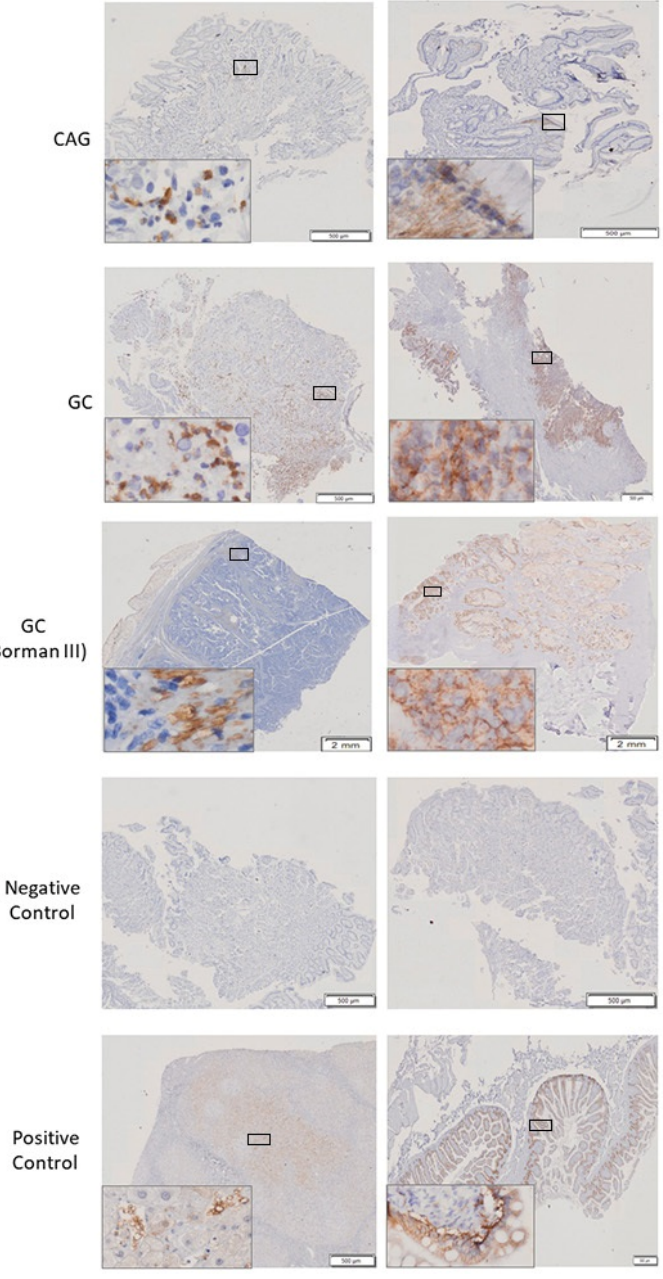
Figure 5. Immunohistochemical staining with MMP9 and CLDN1 in different gastric tissues (brown indicates positive). Antral gastric mucosa without significant histological alterations [Gastric biopsy (GB)]; Mild chronic follicular gastritis with mild activity associated with H. pylori (CFG); Moderate chronic atrophic gastritis not associated with intestinal metaplasia (CAG); Gastric cancer of the intestinal type well and little differentiated, ulcerated in gastric antrum (GC); Gastric cancer of moderately differentiated, ulcerated, exophilic intestinal phenotype (T3, circumferential) gastric resection (GC T3); Negative control: gastric biopsy without alterations that does not show staining because the primary antibody was omitted; Positive control of MMP9: Liver Explant; Positive control of CLDN1: Colon. (GB–GC): scale bars = 500 µ m; (GC T3): scale bars = 2 µ m (40 × amplification) and inset it’s 100 × . The images were captured with the Olympus BX61VS